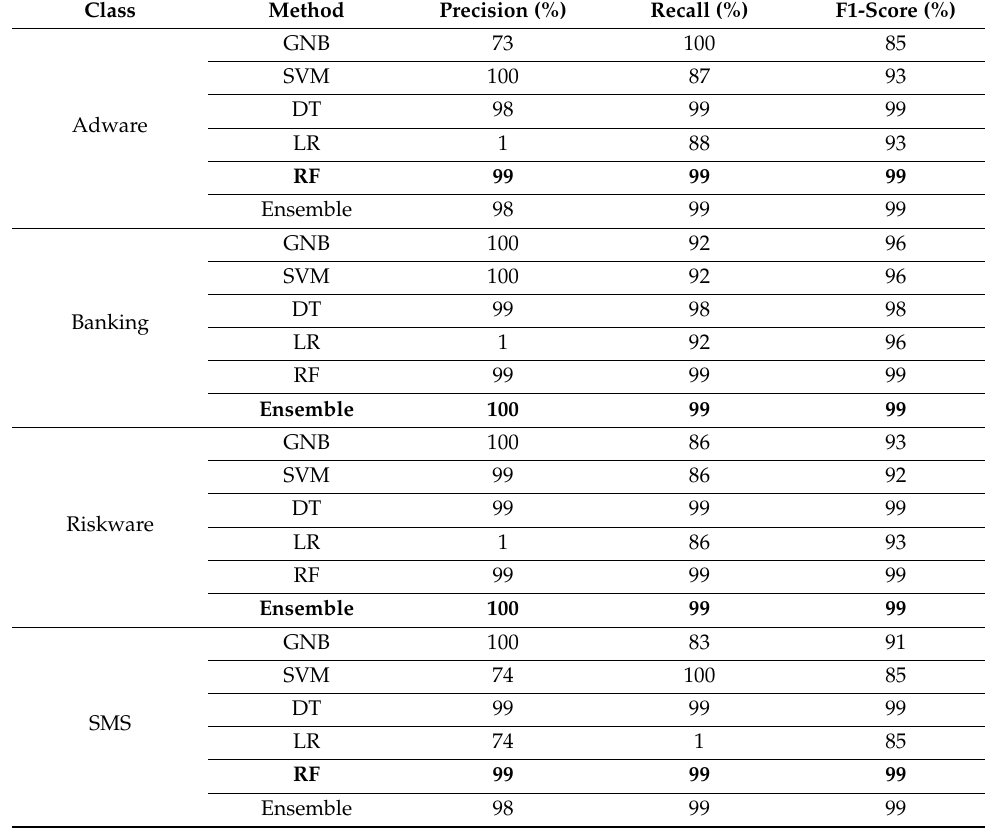
Table 7. Per-class performance comparisons for malware classification using dataset 2 with 256 × 256.